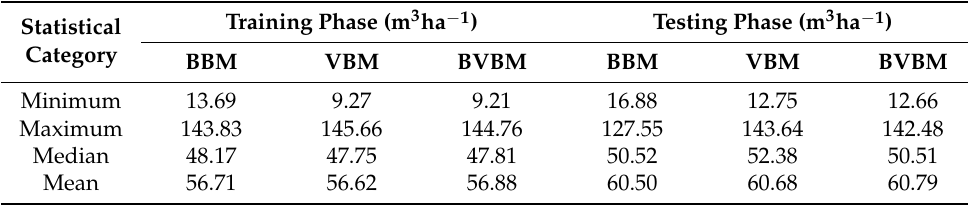
Table 6. Characterization of FSV predicted by the three models.